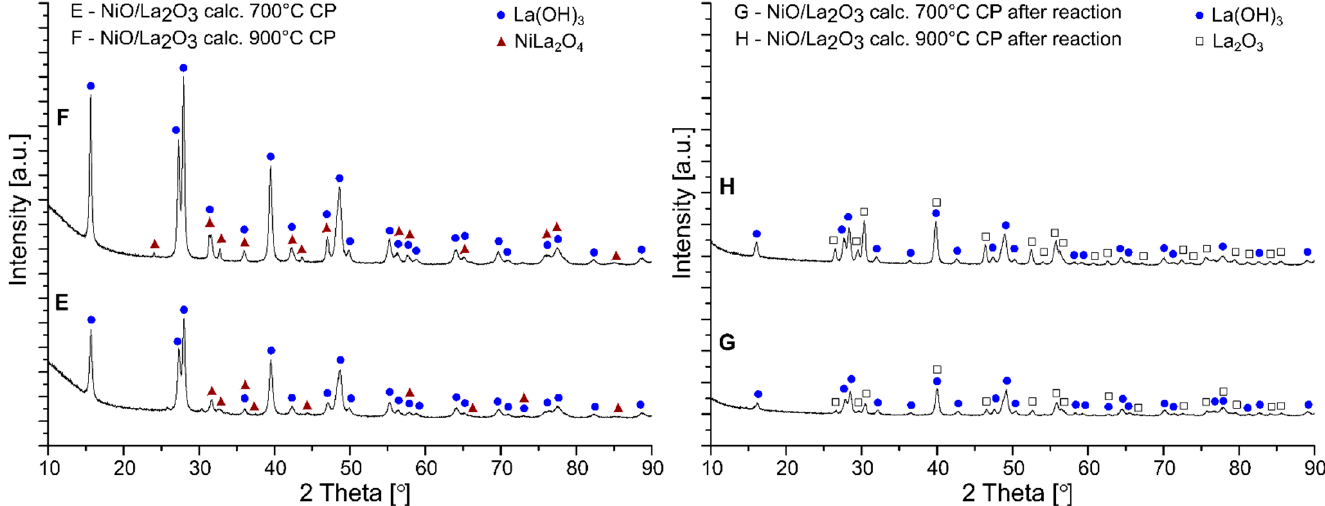
Figure 6. XRD diffraction patterns recorded for the NiO/La 2 O 3 catalysts prepared by co-precipitation method and calcined in an air atmosphere for 4 h at 700 and 900 °C and for spent systems.